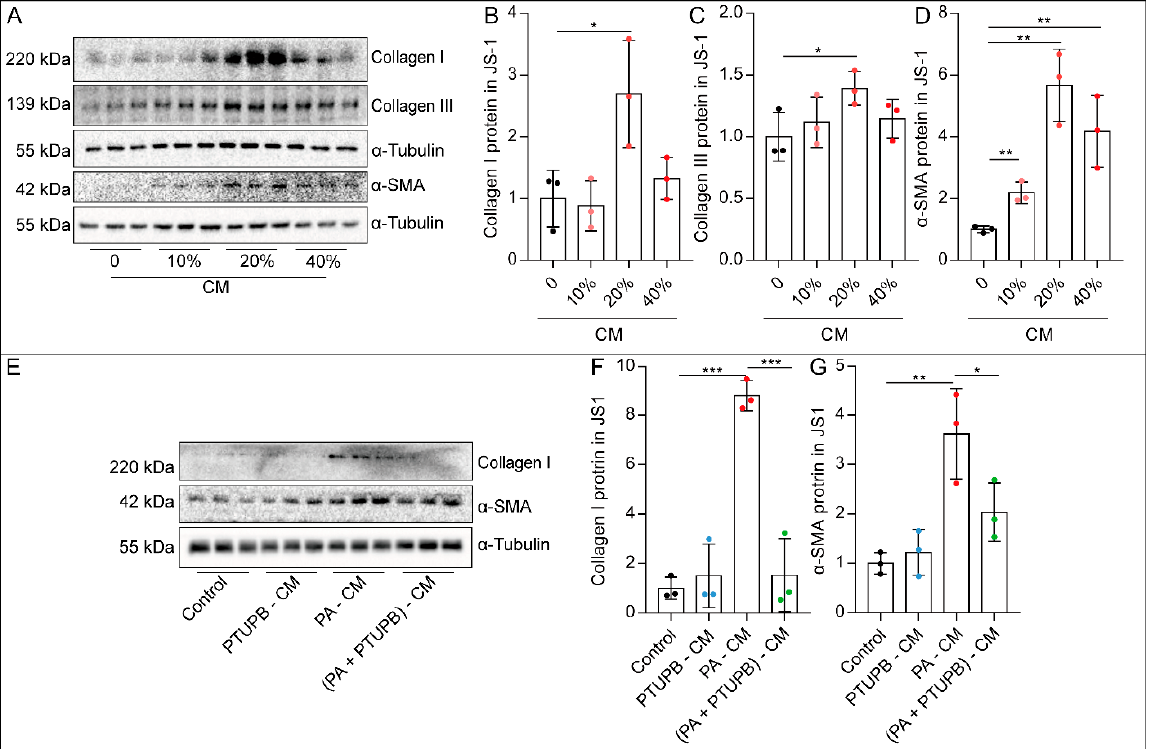
Figure 4. PTUPB reduces hepatic astrocyte activation by inhibiting hepatocyte senescence. AML12 cells were treated with PA (200 µ M) for 48 h, and cell culture supernatant was collected as CM. The protein expressions of collagen I, collagen III, and α -SMA in JS1 cells treated with different concentrations of PA-CM stimulation for 48 h were measured by Western blot and quantitatively analyzed (( A – D ), n = 3). The protein expressions of Collagen I and α -SMA in JS1 cells were measured by Western blot and quantitatively analyzed after different CM stimulation for 48 h (( E – G ), n = 3). Data are expressed as the mean ± SD. Differences among multiple groups were performed using ANOVA. Tukey’s test was used as a post hoc test for pairwise comparisons. * p < 0.05, ** p < 0.01, and *** p <